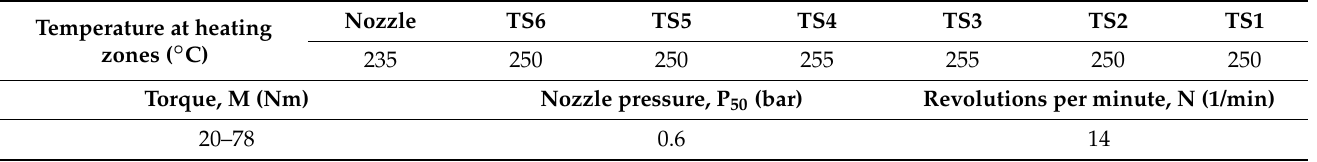
Table 3. The parameters of the extrusion